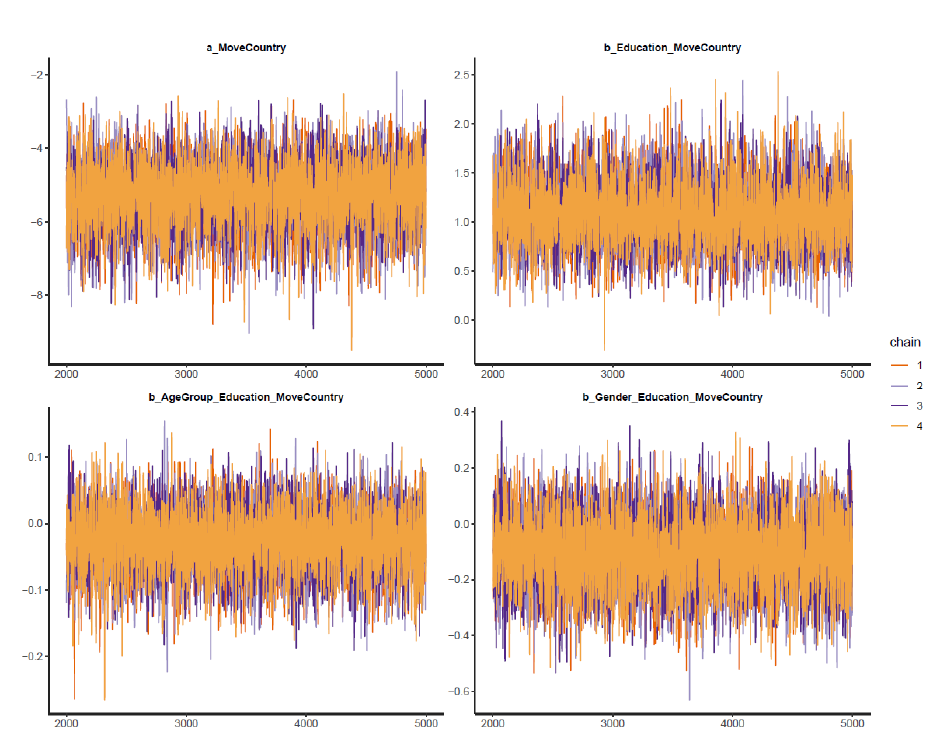
Figure A1. Trace plots for Model 2′s posterior parameters.